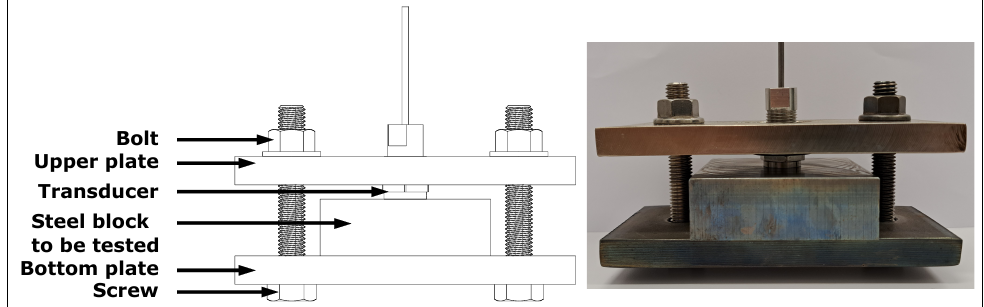
Figure 4. Transducer pressed onto a steel block to be tested on thermal cycles.